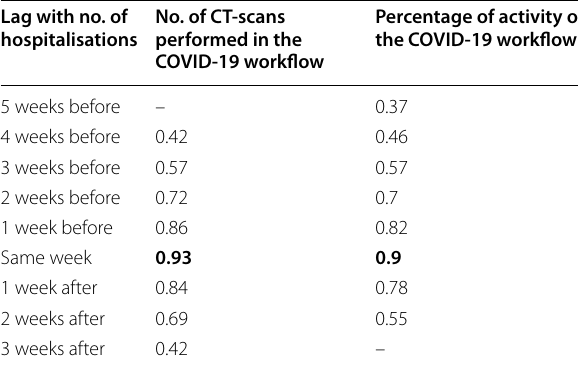
Data in bold correspond to maximum values no.